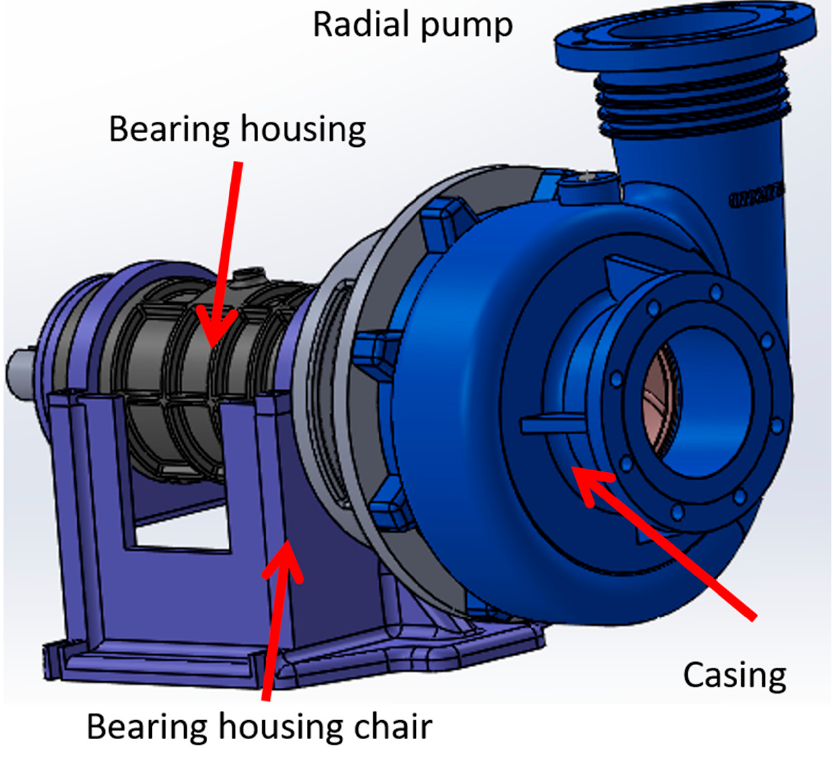
Figure 3. CAD model of the radial pump parts.